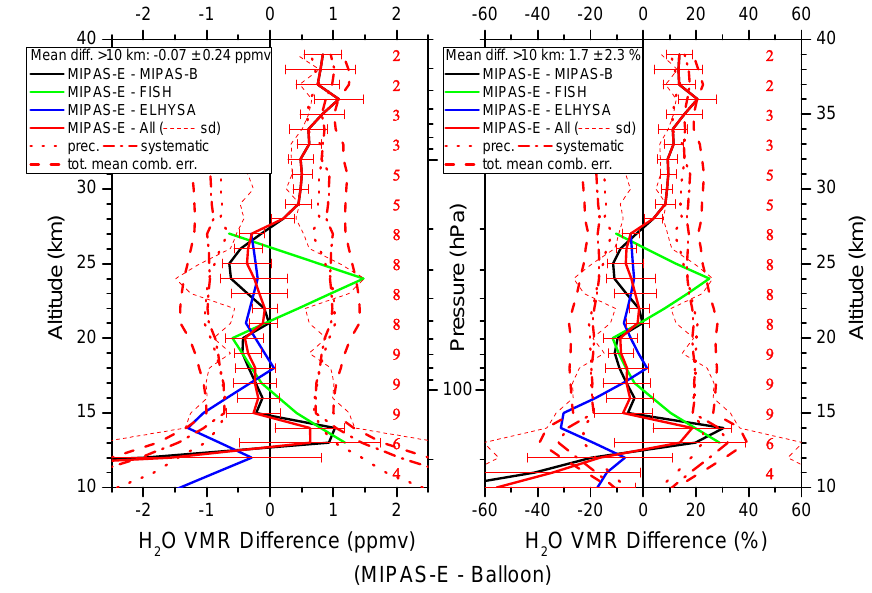
Fig. 7. Differences of all (red solid lines) direct comparisons between MIPAS-E and balloon-borne observations of the instruments MIPAS-B (black solid lines), FISH (green solid lines), and ELHYSA (blue solid lines), together with mean combined precision (red dotted lines), systematic (red dash-dotted lines), and total errors (red dashed lines) as well as standard deviation (red thin dotted lines) and the standard error of the mean, plotted as error bars. Red values (along the right-hand y-axes) indicate the number of collocations at corresponding pressure levels.